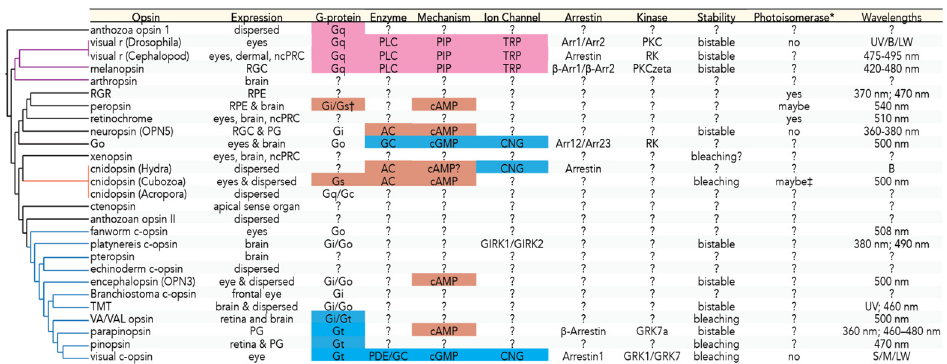
Figure 1. Diversity of opsins and phototransduction cascades. Left : Opsin phylogeny with purple branches for traditional r-opsins, blue branches for c-opsins, orange branches for cnidopsins. Right : Table with opsin characteristics. Typical components of r-opsins are in pink boxes, of c-opsin in blue, and of cnidopsin in orange. * By photoisomerase activity, we refer to chromophore isomerization from trans to cis and release to replenish rhodopsin. † Peropsin was mutated and signaled in the dark; it is likely dark activated. ‡ A different cnidopsin from that used in the eyes for phototransduction. Details of evidence and references are in Supplemental Table S1. Abbreviations: RGC—retinal